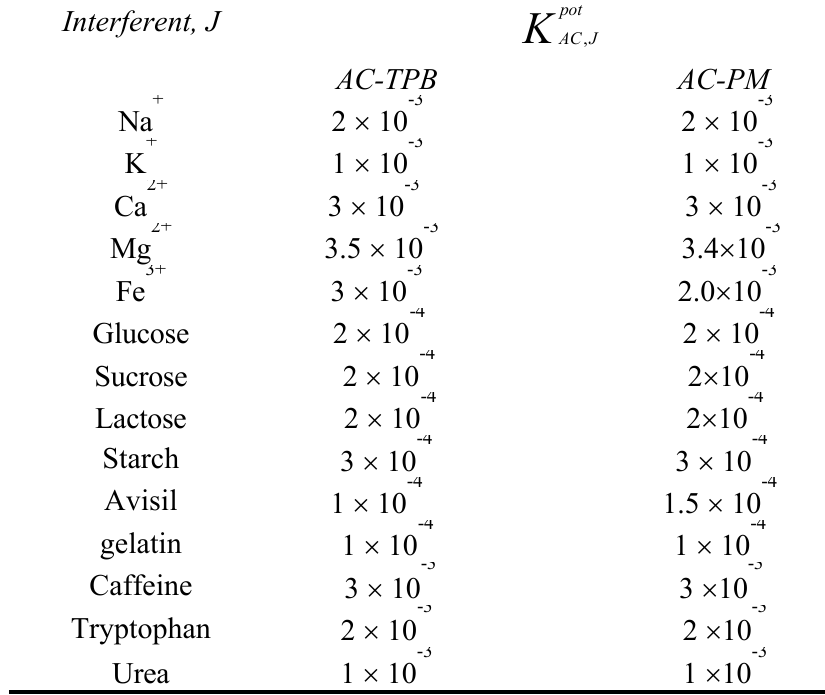
Table 3 . Potentiometric selectivity coefficients ( K pot Interferent,